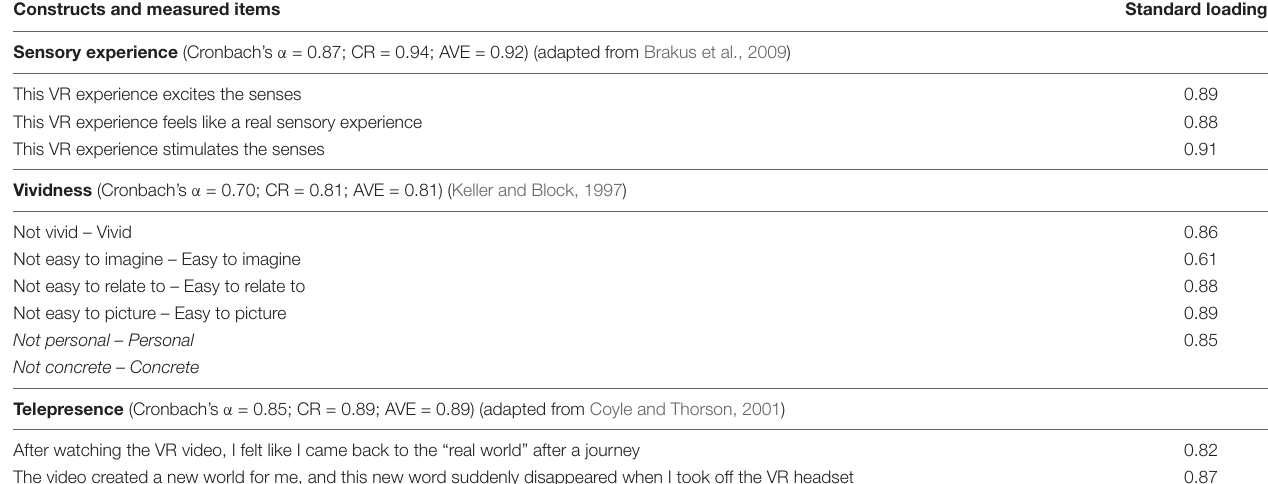
TABLE 1 | Standard loadings, composite reliability and average variance extracted. Constructs and measured items Standard